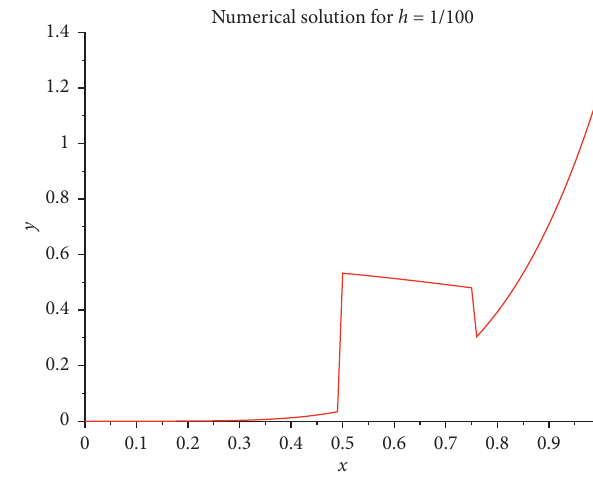
Figure 3: Numerical solution ρ ( 1/1000 ) ( x ) for h � ( 1/100 ) .